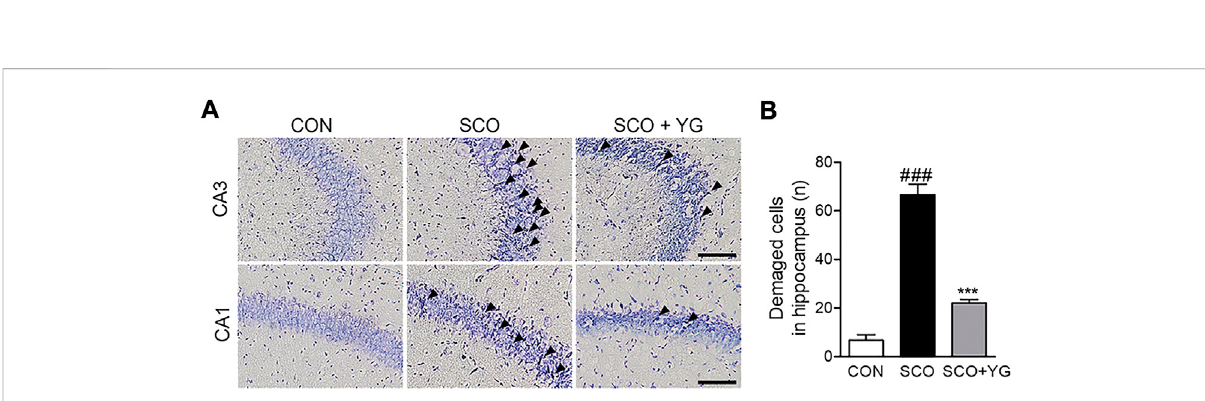
FIGURE 6 Effect of YG on neuronal cell death in scopolamine-induced mice. (A) Photomicrograph and (B) histogram for Nissl staining. All data are presented as the mean ± SEM from three independent mice. Scale bar = 100 μ m ### p < 0.001 vs. CON; *** p < 0.001 vs. SCO. CON; control, SCO; scopolamine, SCO + YG; scopolamine + Yuk-Gunja-tang 150 mg/kg, CA1; cornu ammonis1, CA3; cornu